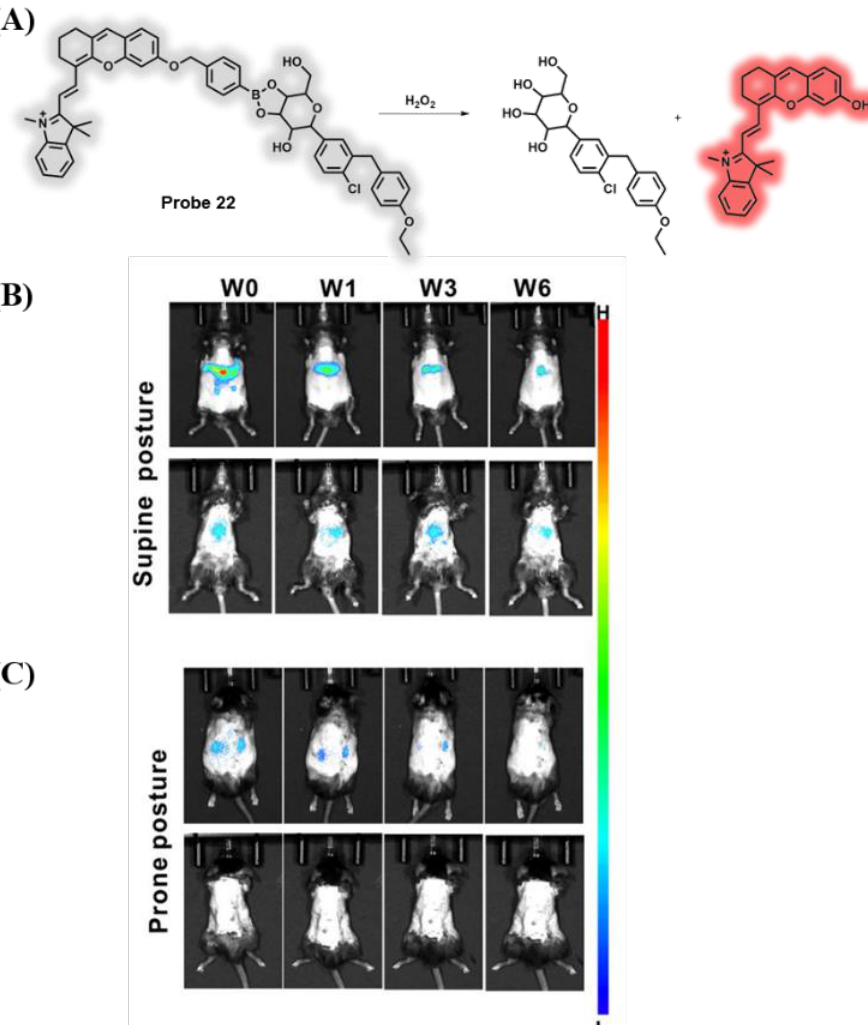
Figure 18. ( A ) Imaging mechanism of probe 22 ; fluorescent images in ( B ) supine posture and ( C ) prone of the control group and the model group at weeks 0, 1, 3, and 6 (therapy course) 15 min after i.v. injection of probe 22 . Adapted from Reference [98]. Copyright 2021, American Chemical Society.